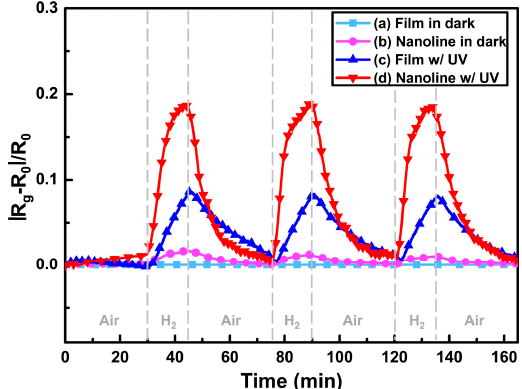
Figure 1. 100 ppm H 2 sensing response plot of ( a ) ZnO thin film in dark; ( b ) 400 nm wide ZnO line in dark; ( c ) ZnO thin film under ultraviolet (UV) light; and ( d ) 400 nm wide ZnO line under UV light. Reproduced with permission from [36].